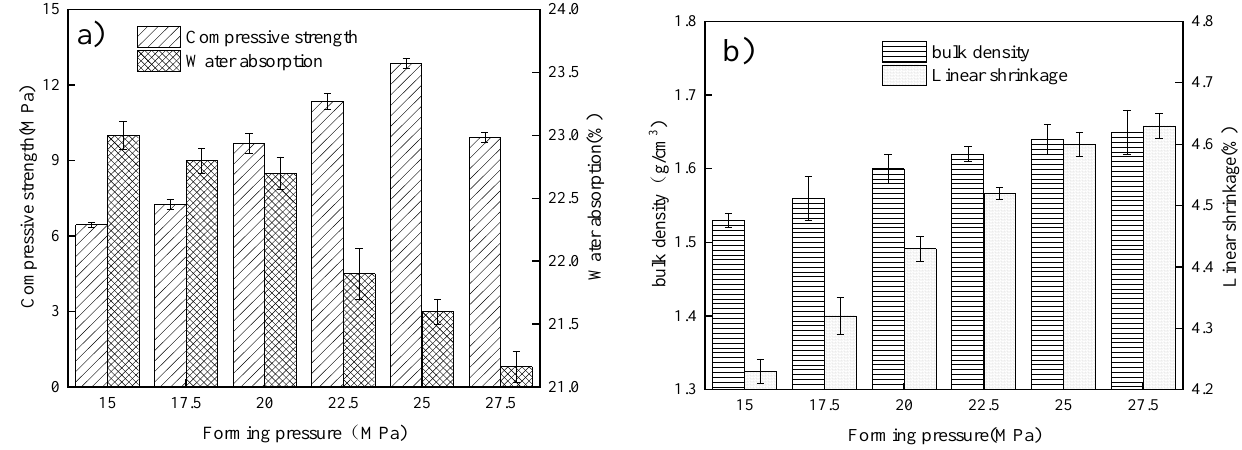
Figure 8. Effect of molding pressure on the characteristics of sintered brick: ( a ) compressive strength and water absorption; ( b ) bulk density and sintering shrinkage.